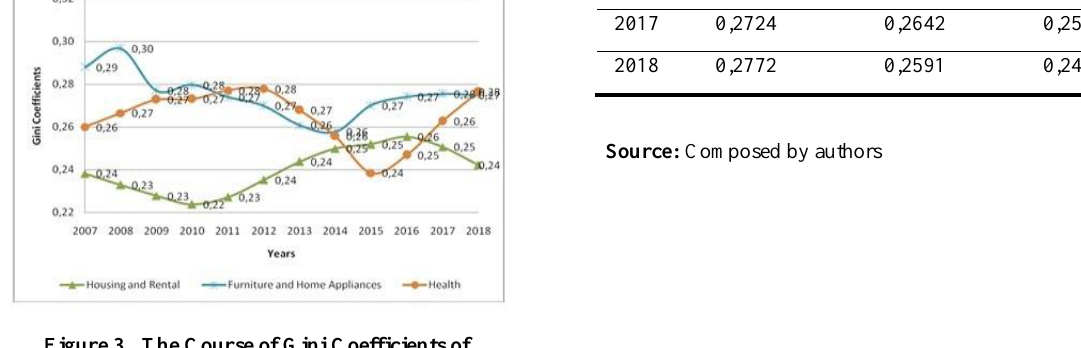
Figure 3. The Course of Gini Coefficients of Inequalities of Expenditure Rates at NUTS-2 Level Regions between 2007-2018